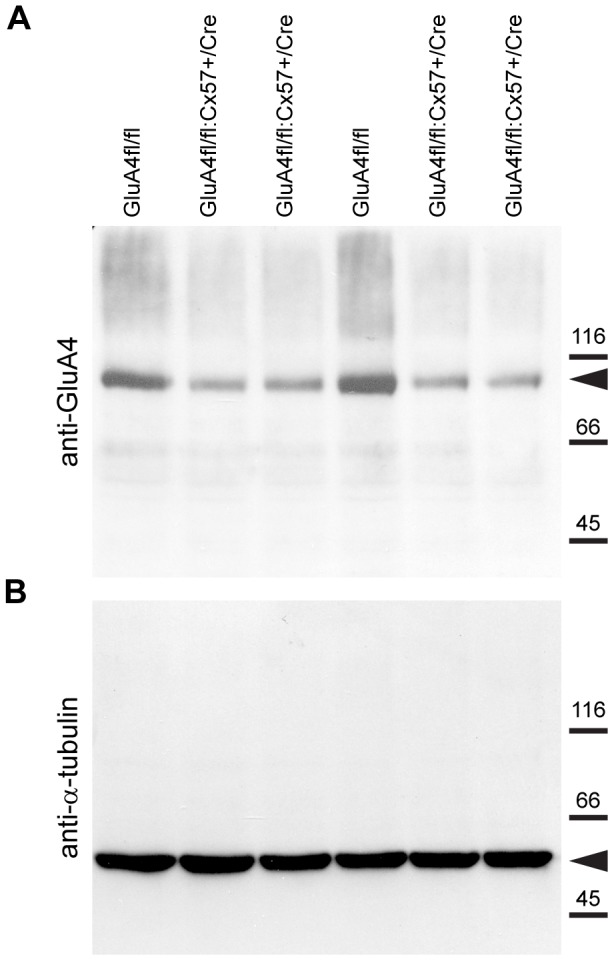
GluA4 protein levels are reduced in retina homogenates from GluA4fl/fl:Cx57+/Cre mice.
A, Western blot analysis of GluA4 expression in retina homogenates from GluA4fl/fl and GluA4fl/fl:Cx57+/Cre mice. GluA4-specific antibodies detected a single protein band migrating at ∼100 kDa (arrowhead). Expression levels are lower in GluA4-deficient mice than in controls. B, To control for total protein amount, the blot was stripped and incubated with antibodies against the housekeeping protein α-tubulin. A single immunoreactive band of ∼50 kDa was detected (arrowhead) revealing that protein amounts were comparable in homogenates from both genotypes. Molecular mass marker proteins are indicated on the right (kDa).